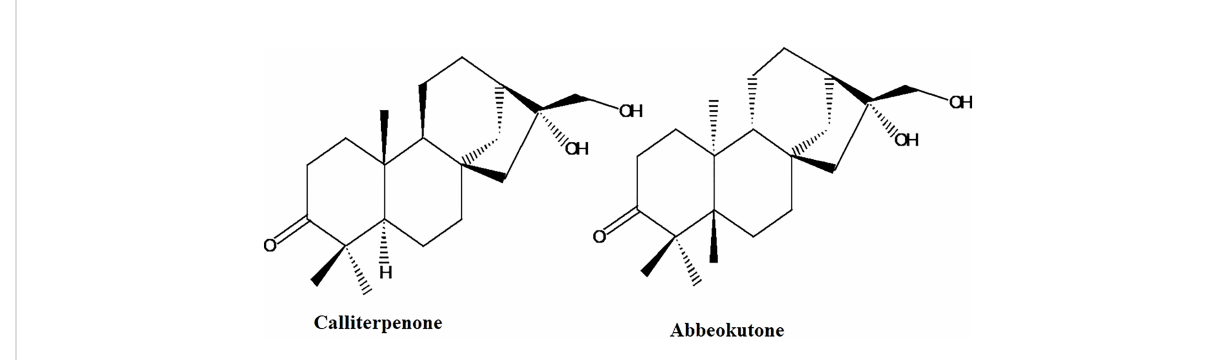
FIGURE 1 Structure of calliterpenone and